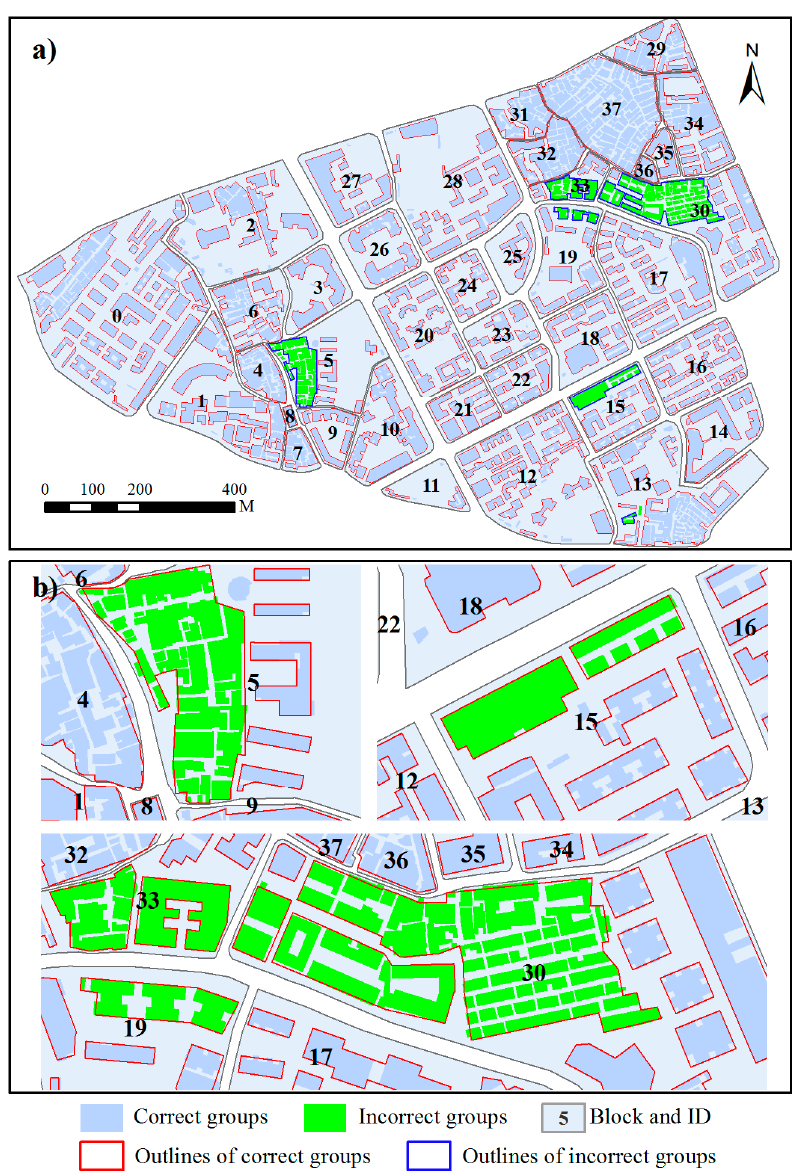
Figure 11. The same as Figure 4 with ID block but grouping results of the tested data are shown for ( a ) the proposed method; and ( b ) an enlarged version of incorrect groups. Buildings marked in green with blue edges are incorrect groups.